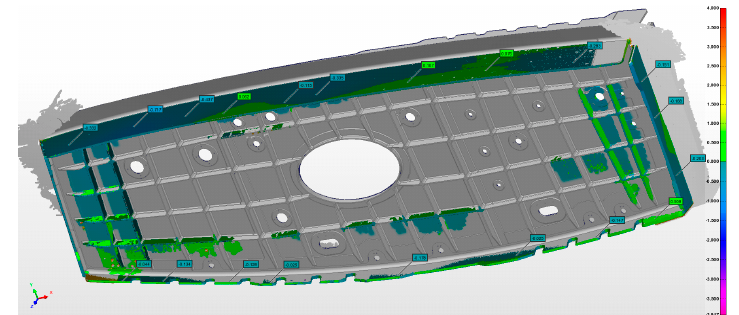
Figure 11. The result of wing box point cloud data alignment and gap evaluation.